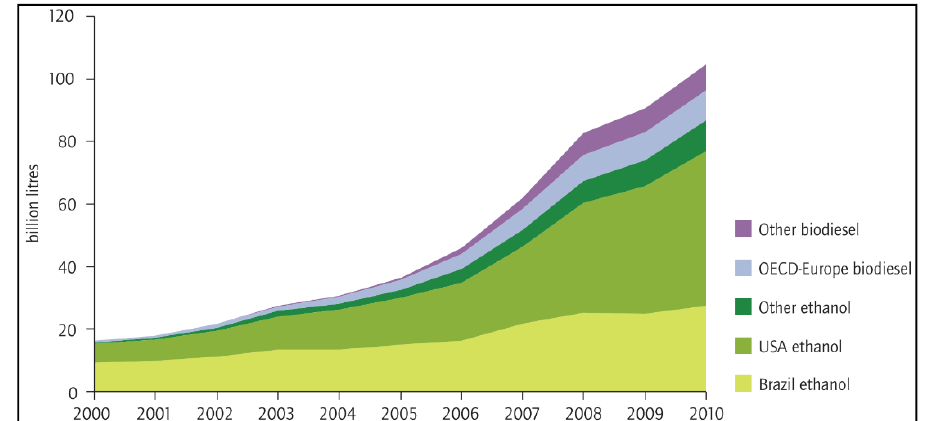
Figure 1. Global biofuel production (adapted from IEA 2011 [28]).